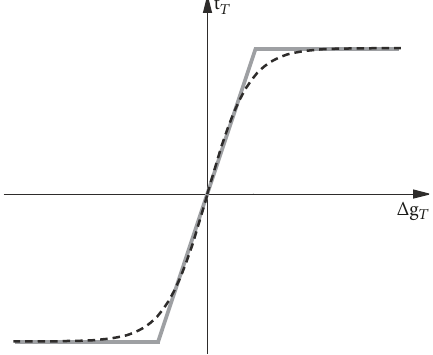
Figure 8: Regularization of the stick-slip